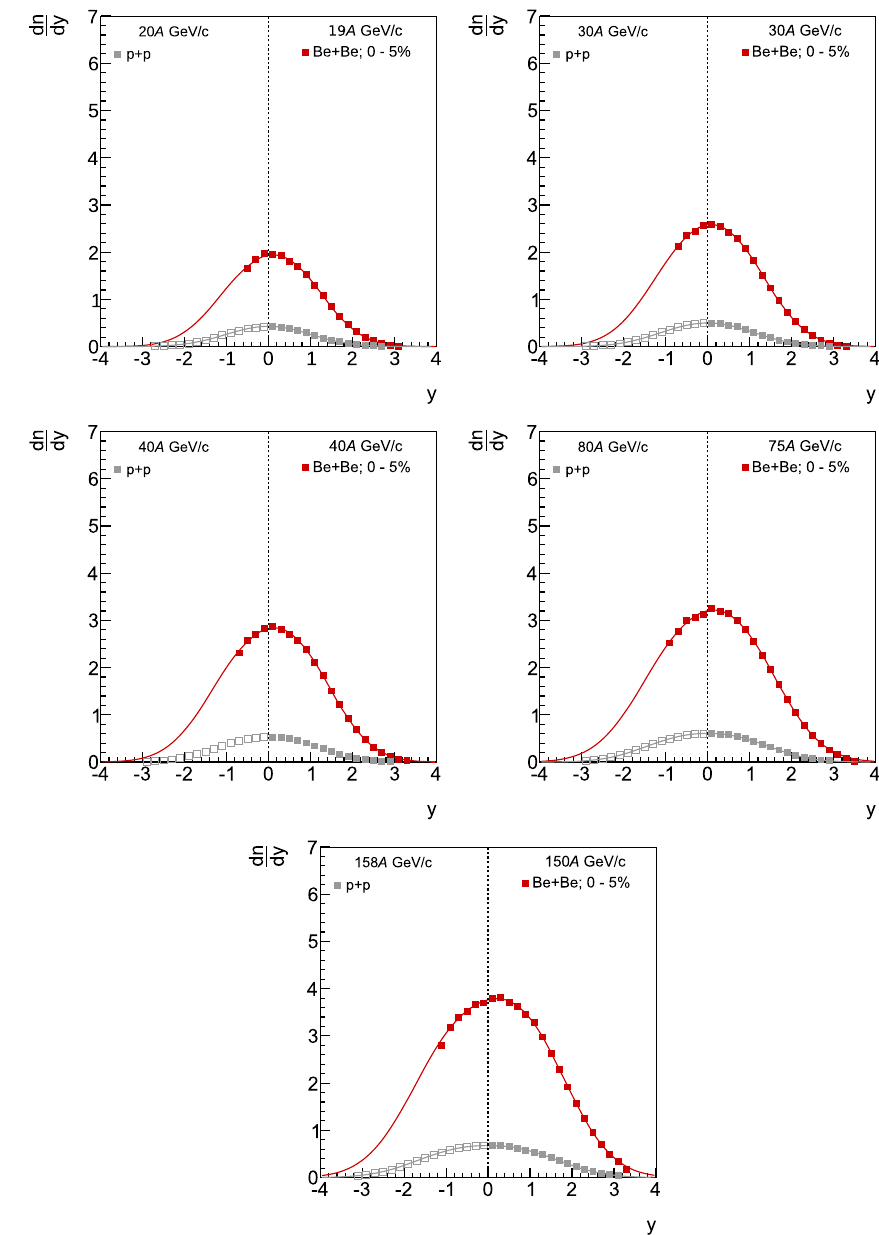
Fig. 16 Rapidity spectra of π − produced in the 5% most central Be + Be collisions at the SPS energies. Results from inelastic p+p interactions [12] are shown for comparison. Statistical errors are smaller than the size of the markers